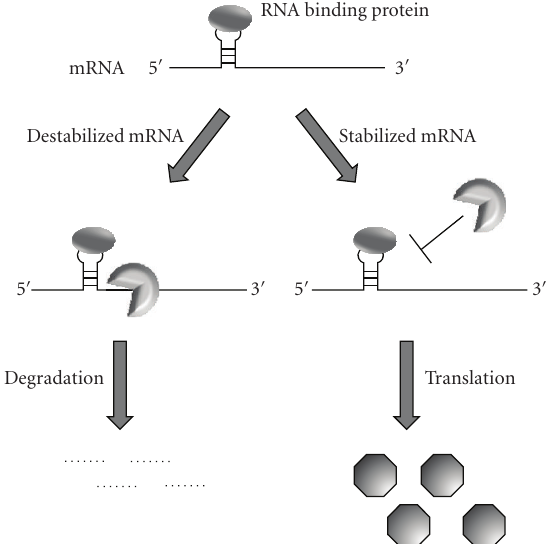
Figure 2: RNA binding proteins a ff ect mRNA stability. RNA bind- ing proteins a ff ect gene expression by stabilizing or destabilizing mRNA targets by altering their susceptibility to RNases. RNA binding proteins may inhibit protein production by destabilizing mRNA molecules which results in RNase-mediated degradation. Alternatively, RNases may be inhibited by RNA binding proteins which stabilizes the mRNA resulting in increased protein produc-